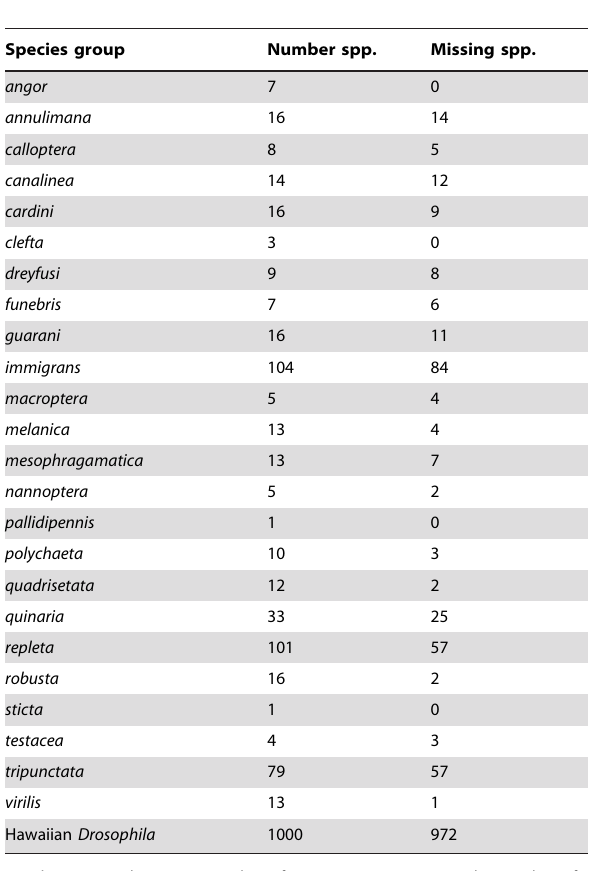
Table 1. Summary data for the species groups of the Drosophila subgenus.